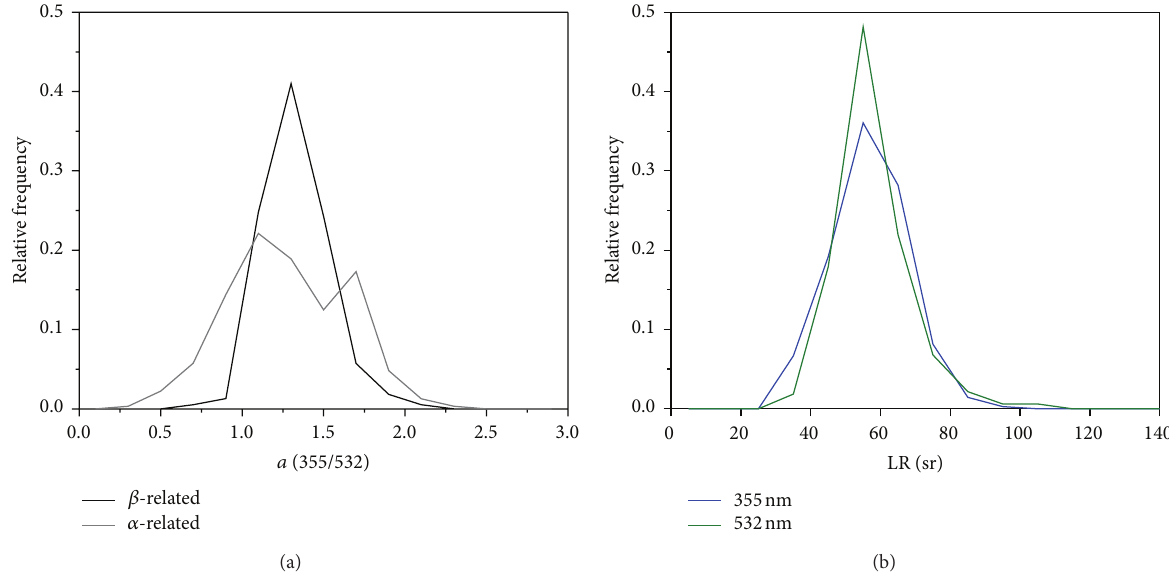
Figure 7: Relative frequency distributions of (a) backscatter and extinction related ˚Angstr¨om exponents (355/532 nm) and (b) lidar ratios at 355 and 532 nm, considering the four different periods of measurements on 17, 18, and 19 October